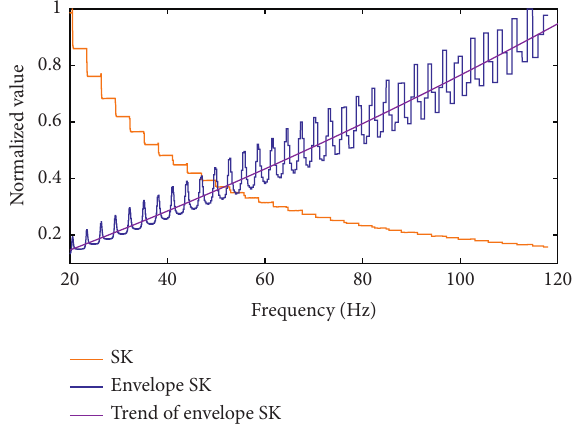
Figure 3: Variation trend of fault characteristic frequency with the normalized value of SK and